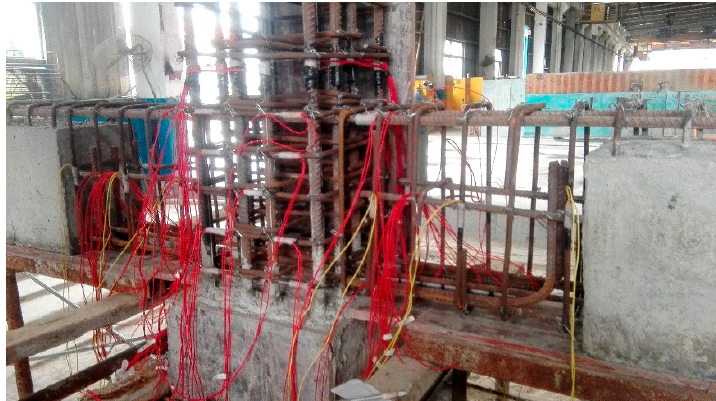
Figure 4. Construction of the keyway area of precast prestressed concrete joints.